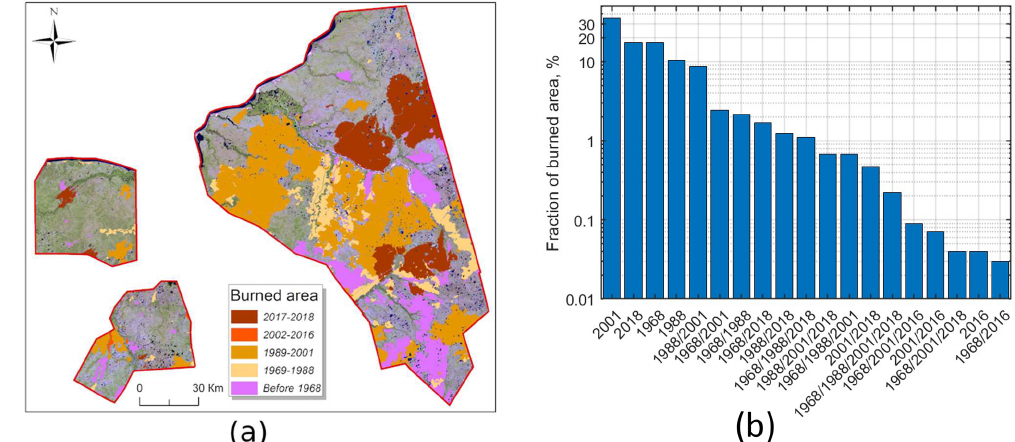
Figure 6. (a) Burned territories within study areas 1, 2 and 3 shown in Landsat 8 mosaic (2018). Dates in the legend correspond to different fire periods or different major fires. (b) The fraction of burned area defined as the burned area in the mosaic from a particular year or years divided by the total burned area during the whole study period. Each year marks the end of the corresponding period mentioned in Fig. 6a. Multiple years on the x axis correspond to multiple fires at the same